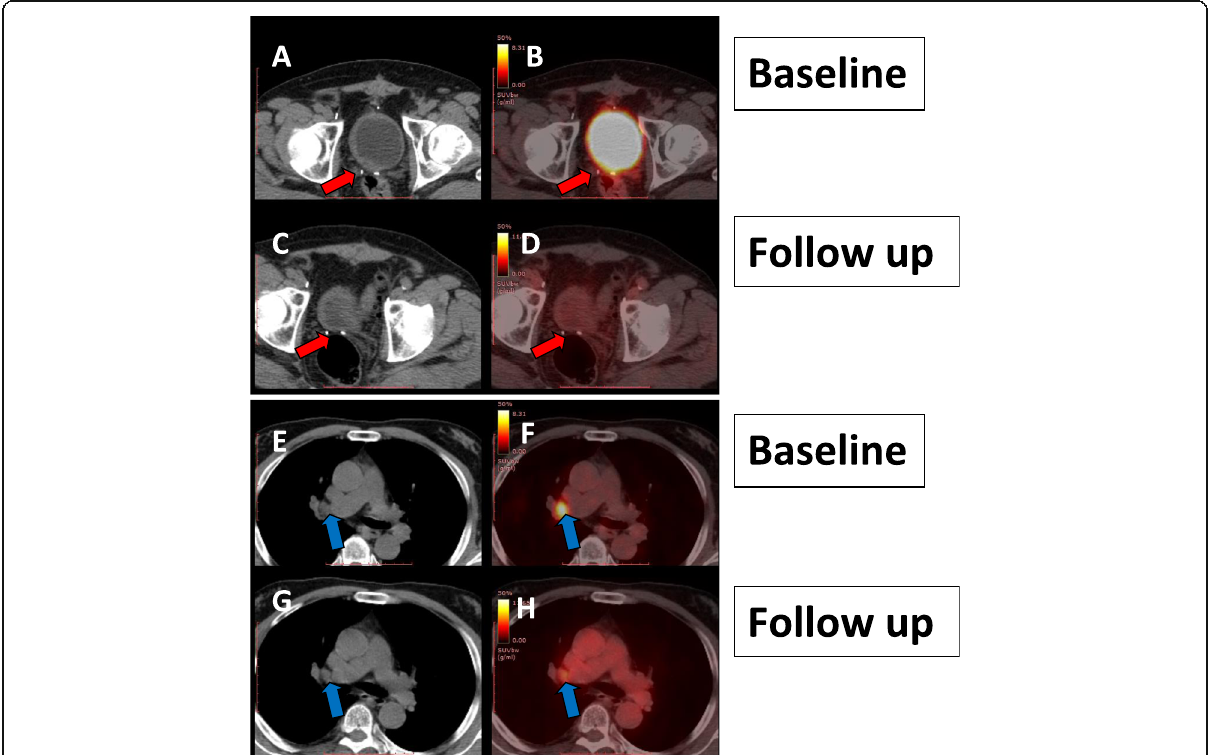
Fig. 2 Axial non-contrast CT and PET-CT images for a 72-year-old male patient with history of prostate cancer for which he had operation, chemotherapy, and hormonal therapy. Images a and b (baseline study) showed no 68Ga-PSMA activity at the operative bed with no significant changes in images c and d (follow up study) (red arrows). Images e and f (baseline study) showed 68Ga-PSMA activity by enlarged metastatic right hilar lymph node measuring 14 mm with SUVmax = 11.7 and showed activity regression in images g and h (follow up study) with SUVmax = 7.3 (blue